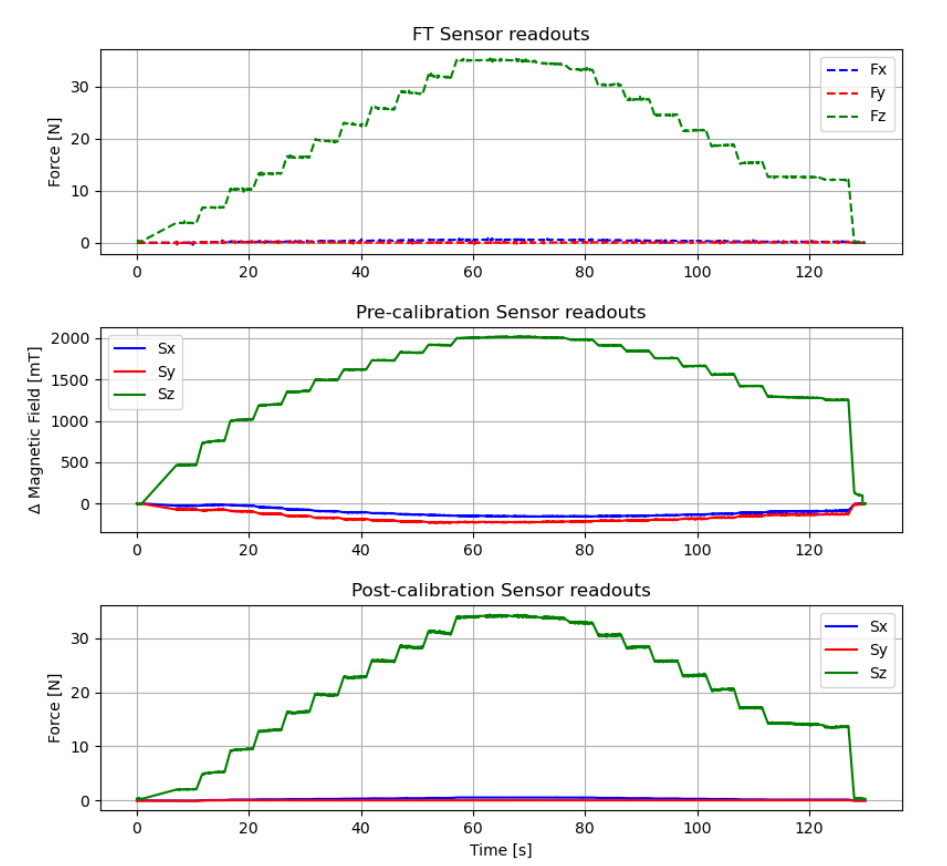
Figure 10. Calibration results for Huber linear regression with polynomial second-degree model. The coil was powered with 500 mA.